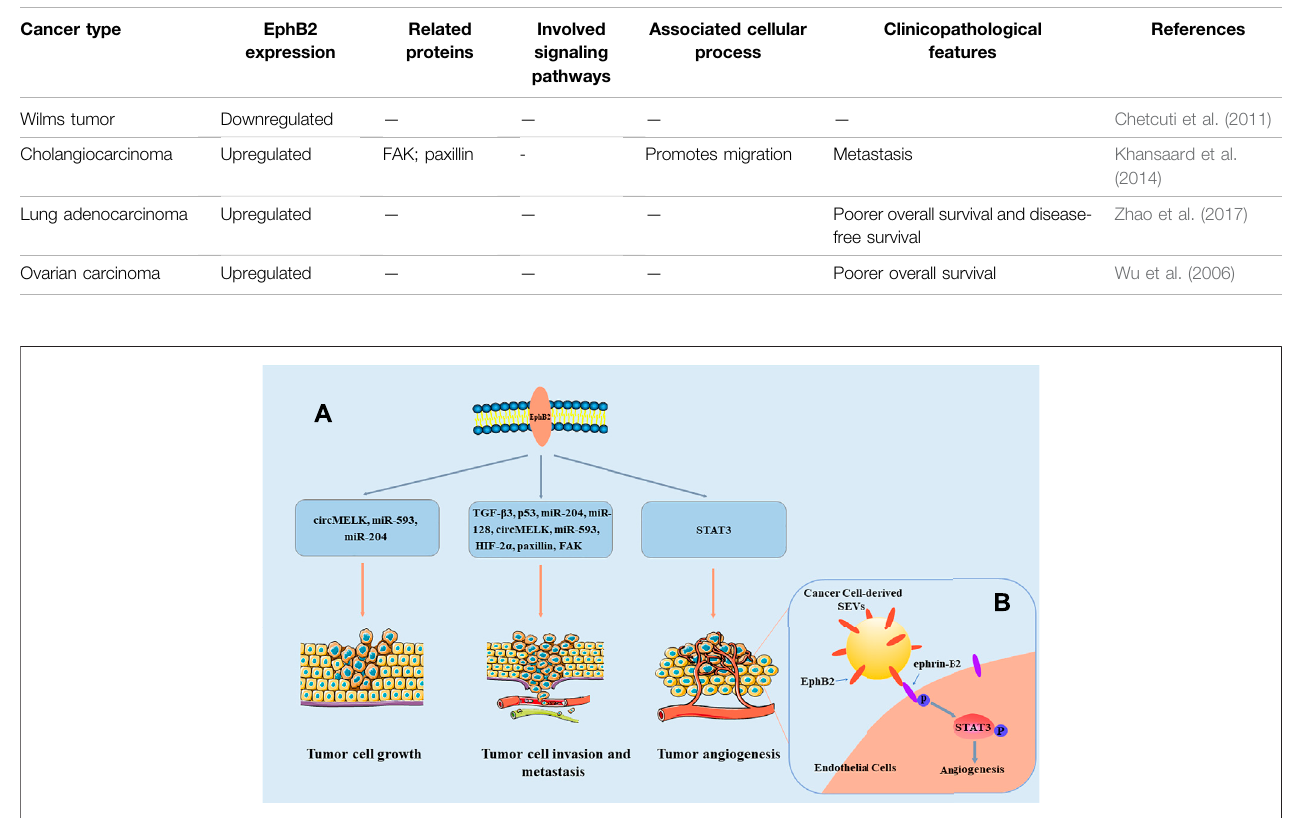
FIGURE 2 | Overview of the roles of EphB2 in cancer. (A) EphB2 exerts its roles in tumor cell growth, invasion and metastasis, as well as angiogenesis through multiple signaling pathways. (B) Model of SEV-induced angiogenesis pathway. EphB2 on cancer cell – derived small extracellular vesicles (SEVs) binds to ephrin-B2 on endothelial cells, and induces ephrin-B2 reverse signaling through downstream phosphorylation and activation of STAT3, thereby promoting angiogenesis (Sato et al., 2019).